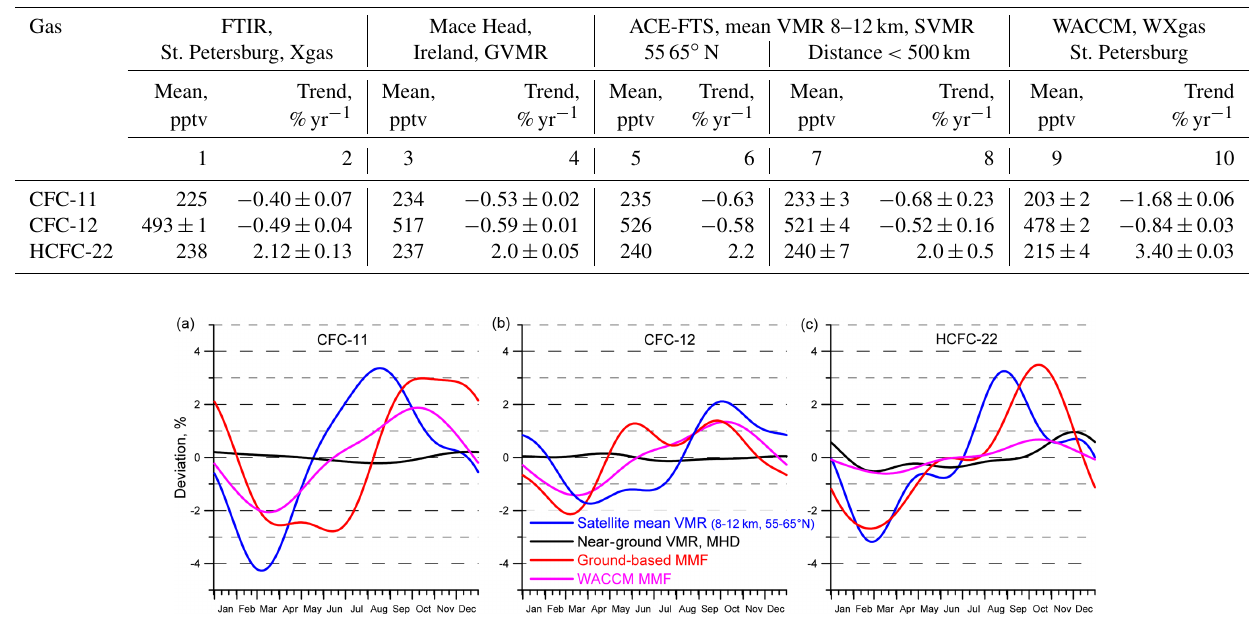
Figure 7. Seasonal relative variability in CFC-11 (a) , CFC-12 (b) , and HCFC-22 (c) . Satellite refers to the ACE-FTS measurements; ground- based and WACCM refer to the FTIR measurements and numerical modeling at the St. Petersburg